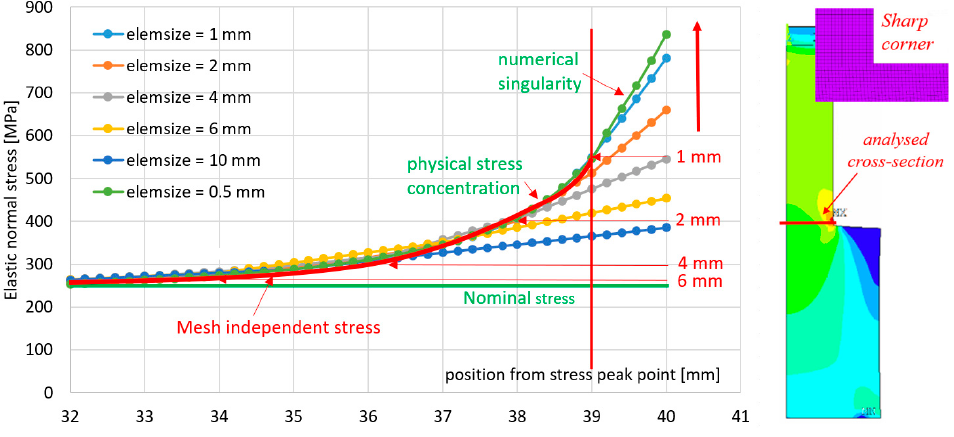
Figure 1. Determination of mesh-independent stresses [13].